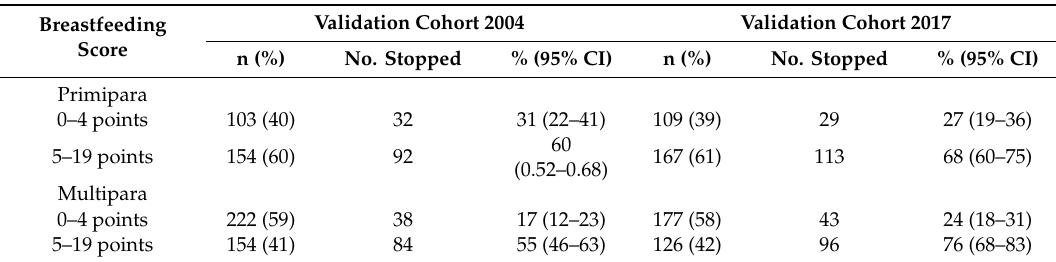
Table 3. Primiparous and multiparous mothers in the validation cohorts divided into risk groups accordingtotheirbreastfeedingscores. Numbersandproportionsofmotherswhostoppedbreastfeeding within 17 weeks in each risk